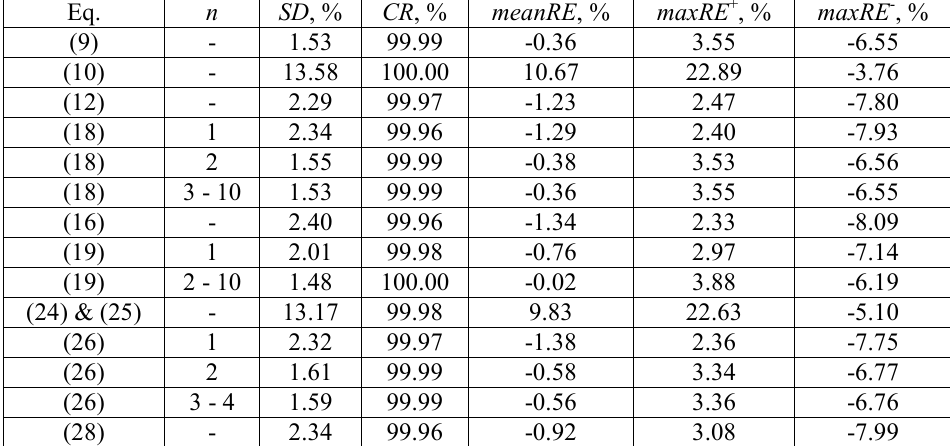
Table 3 Review of the correlations for turbulent flow in rough pipes (database z = 181) Eq.